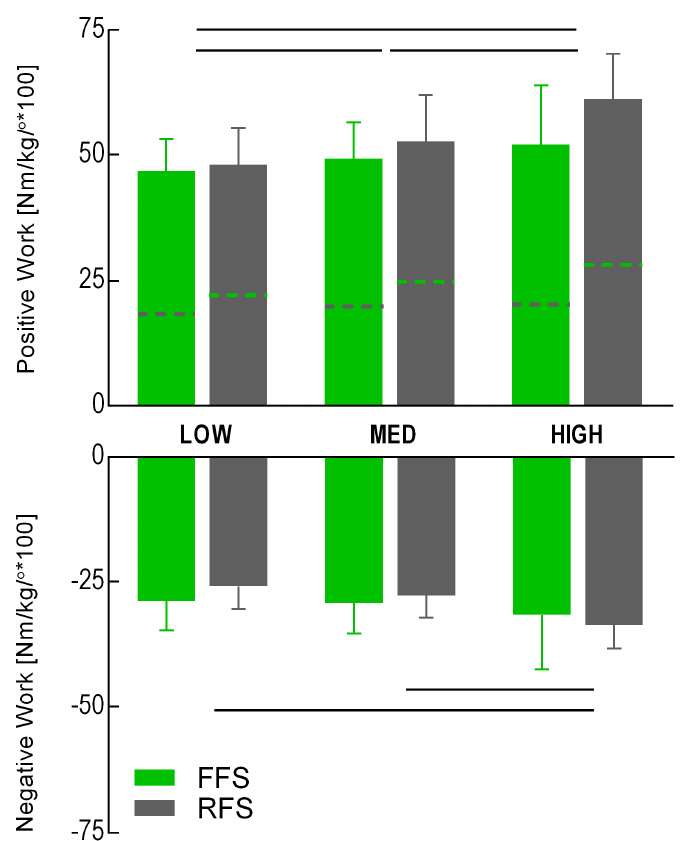
Figure 4. Mean and SD of ankle work for the three footwear conditions. Values are shown for positive and negative work for FFS and RFS. Dashed lines across the bars indicate the net work. Horizontal solid lines above and below the bar graph signify a statistically significant ( p < 0.05) difference between footwear conditions.